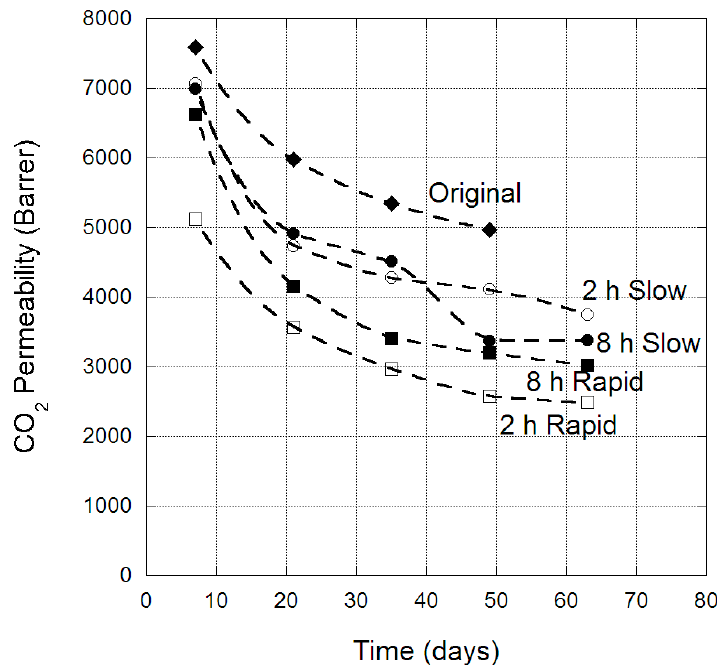
Figure 4. CO 2 permeability (barrer) in PIM-1 membrane over time, for the original and scCO 2 -treated states, at 35 °C.